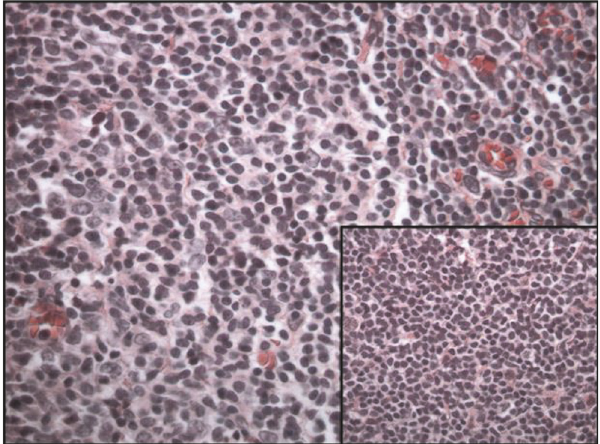
Figure 3: Mantle cell lymphoma involving the thyroid and prela- ryngeal lymph node (insert), stained with Hematoxylin and Eosin